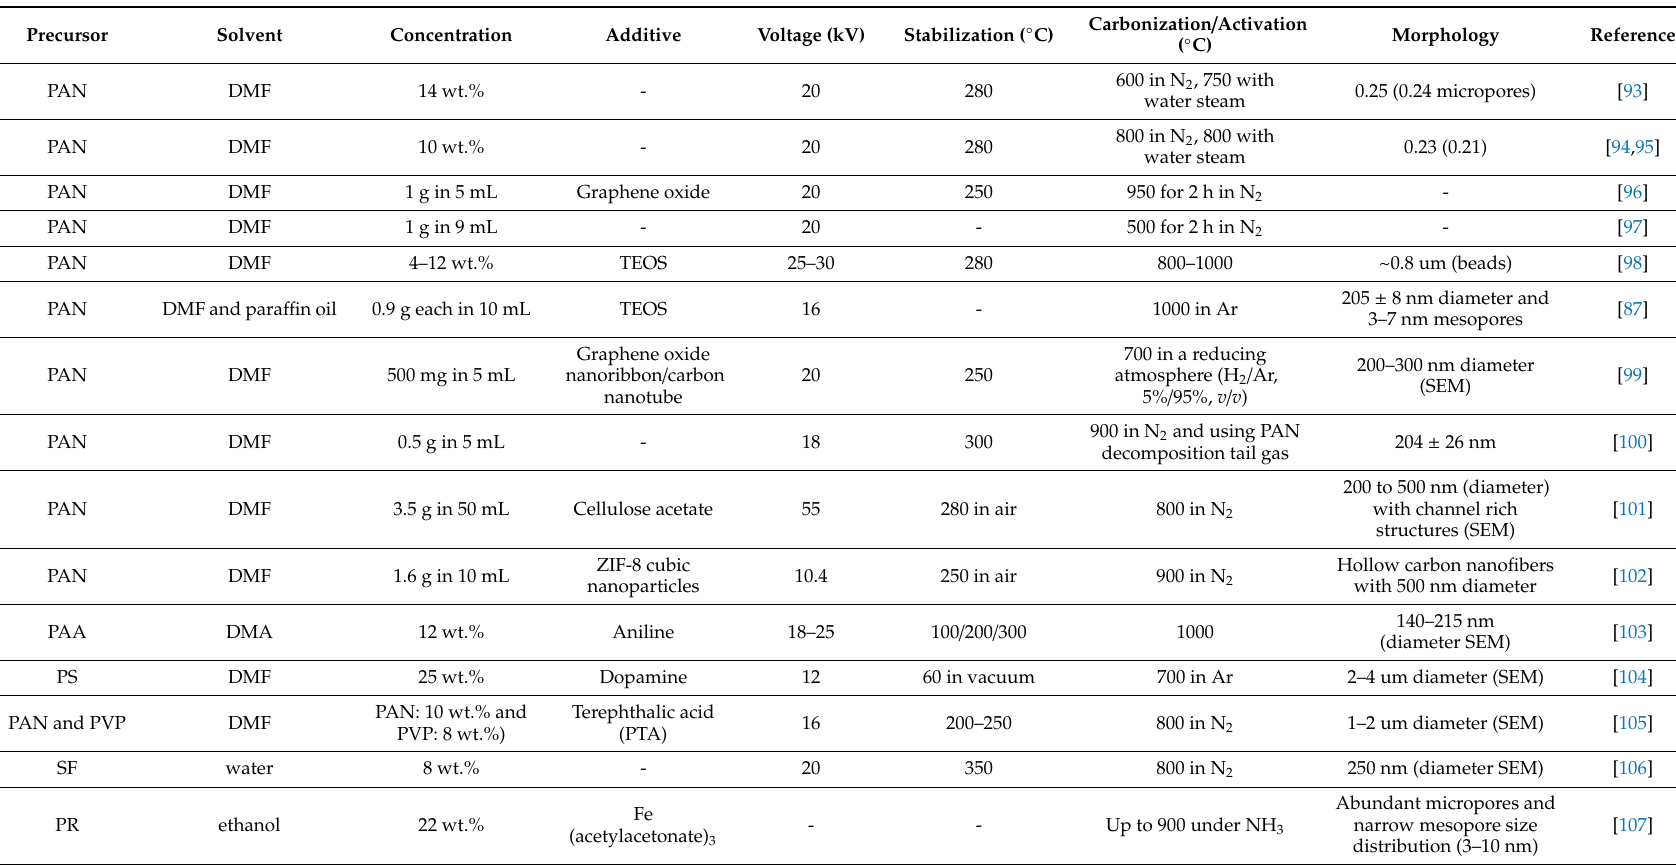
Table 1. Summary of the reported preparation methods of carbon nanofiber membranes and free-standing films by